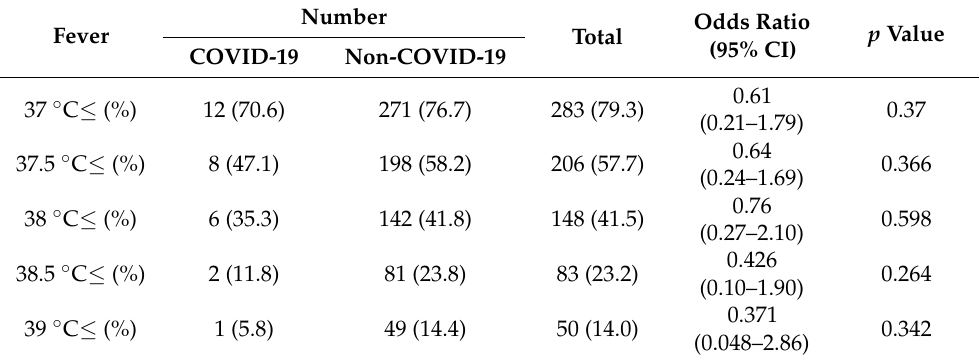
Table 2. Number and percentage of patients having fever over each temperature (37.0, 37.5, 38.0, 38.5, 39.0), and crude odds ratios and 95% confidence intervals of risk factors for COVID-19 at each temperature,